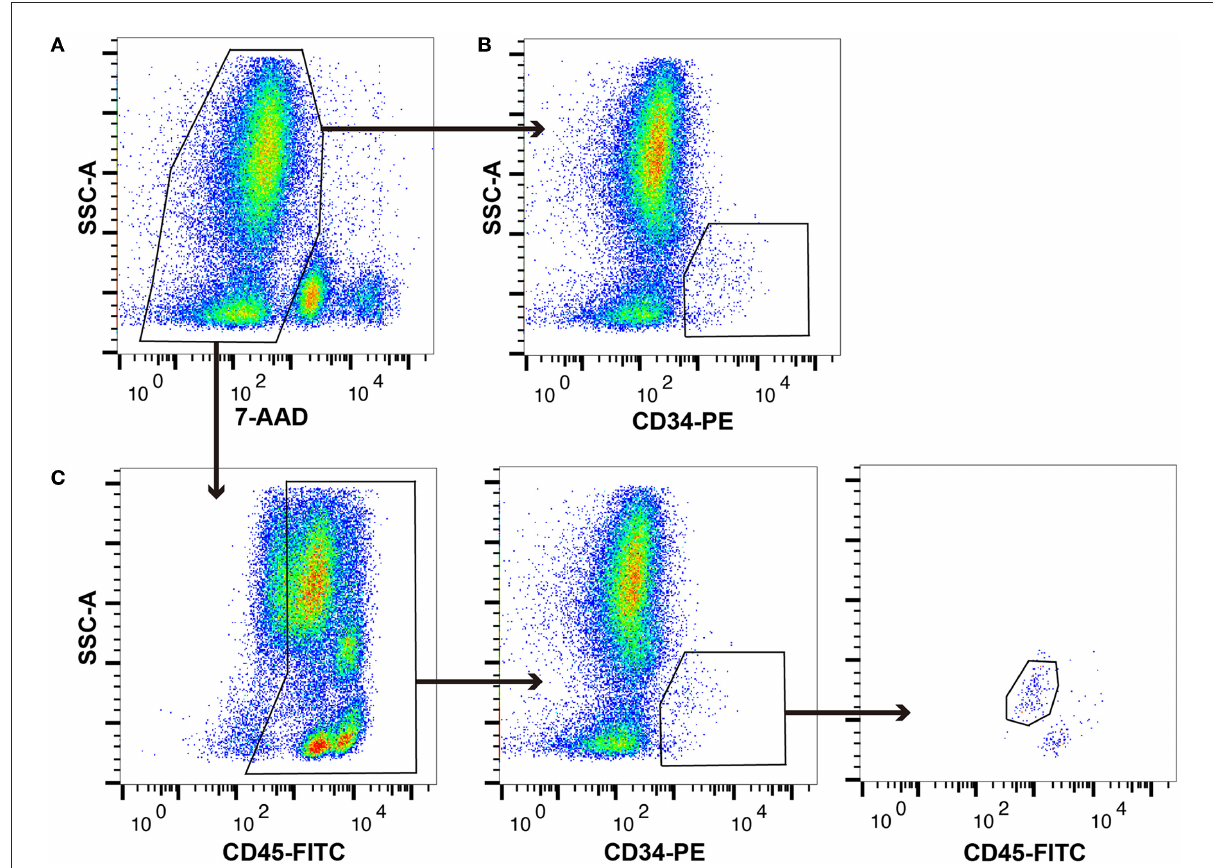
FIGURE1 Typical plot profiles of canine haematopoietic stem and progenitor cells (HSPCs). Canine bone marrow-derived mononuclear cells (cBM-MNCs) were stained with 7-aminoactinomycin D (7-AAD), which is a viability dye, phycoerythrin (PE)-labelled anti-canine CD34 monoclonal antibody (mAb), and fluorescein isothiocyanate (FITC)-labelled anti-canine CD45 mAb. (A) Whole viable cells, (B) CD34 + cells, and (C) CD34 + /CD45 diminished (CD45dim) cells as analysed by flow